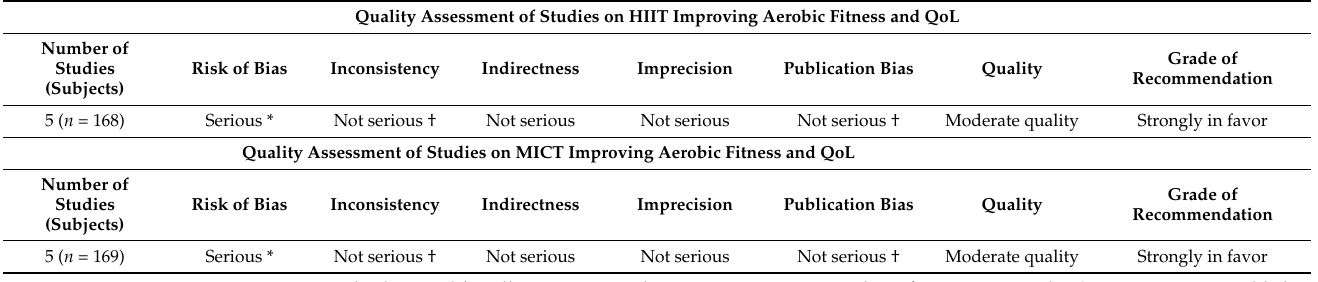
Table 4. Summary of findings for clinical trials using the GRADE quality of evidence assessment. Quality Assessment of Studies on HIIT Improving Aerobic Fitness and